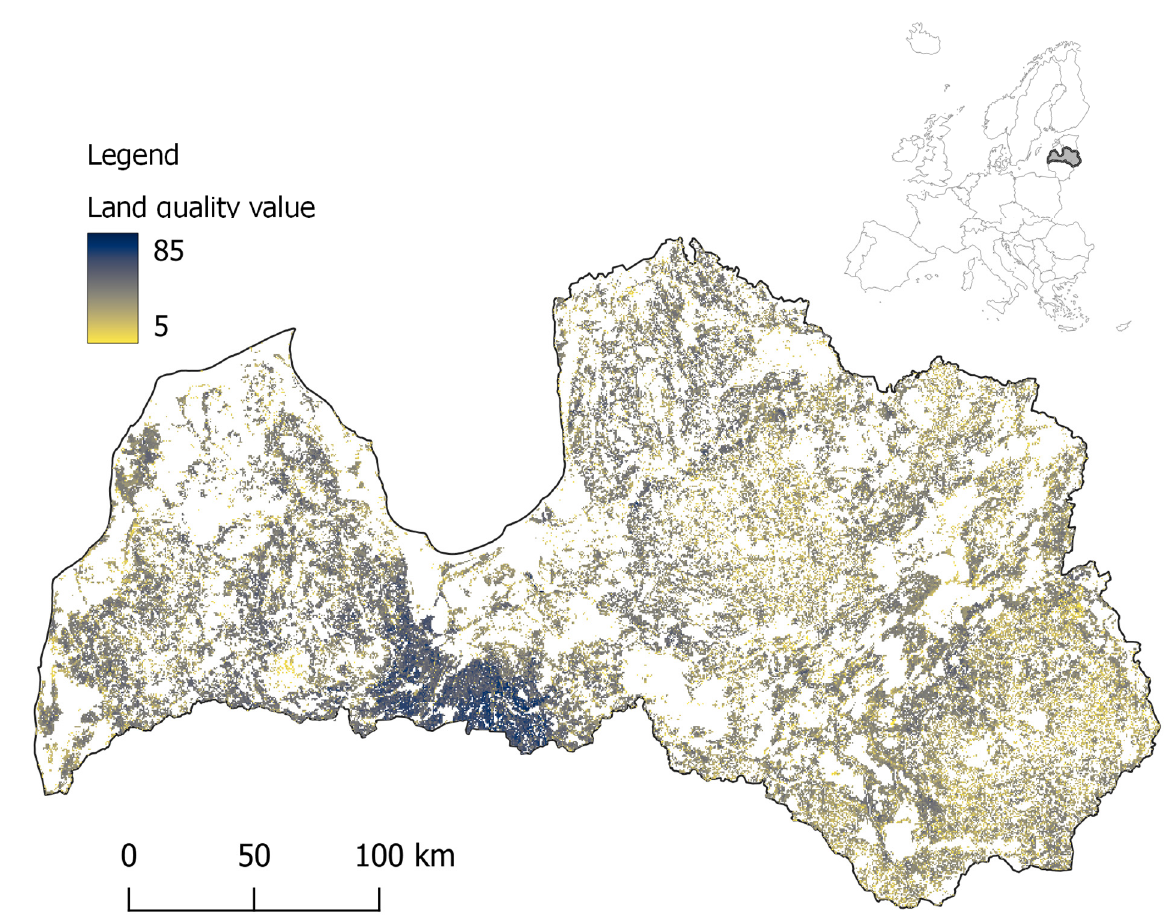
Figure 1. Distribution of land-quality values of agricultural land in Latvia.